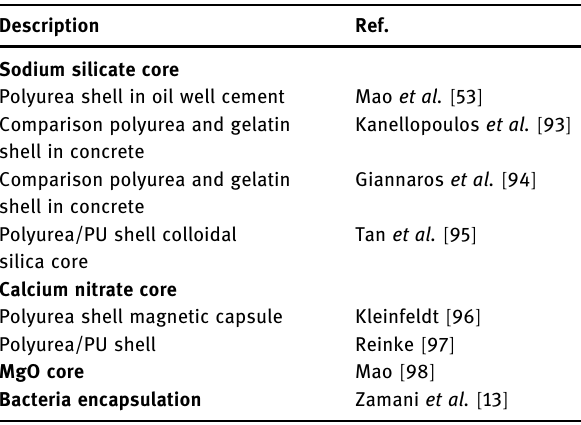
Table 3: Polyurea micro - /nano - capsule for self - healing concrete